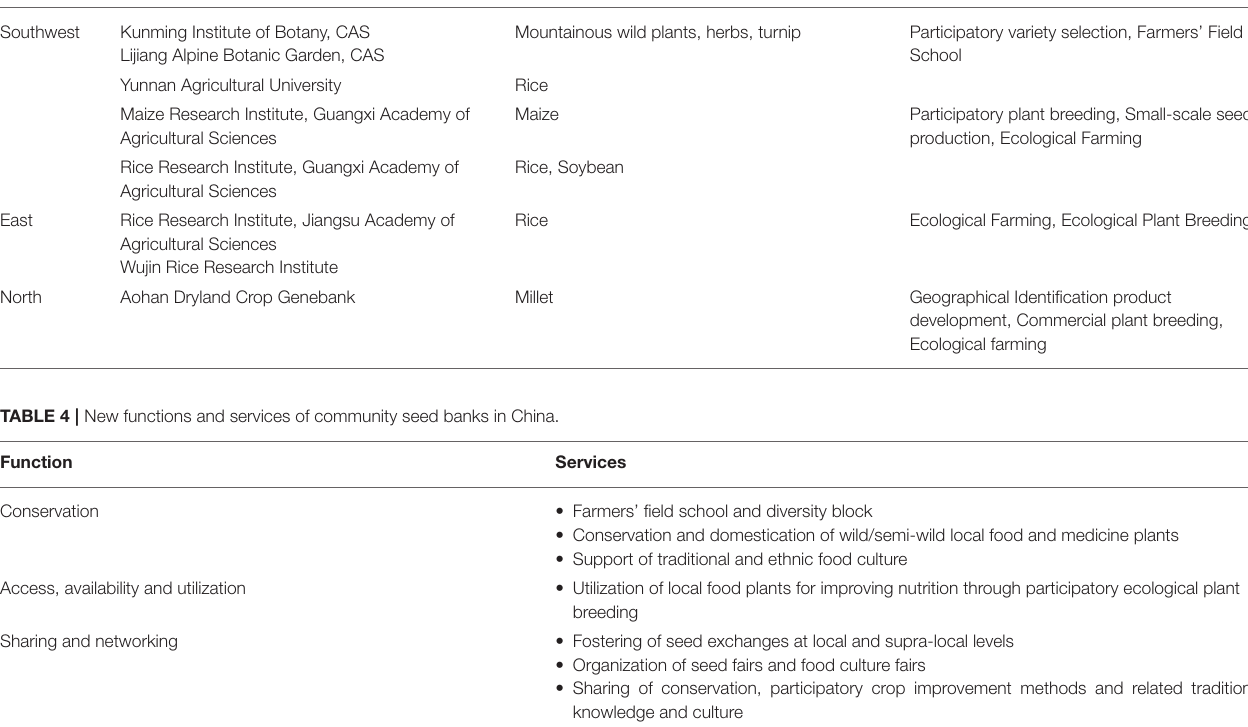
TABLE 3 | Organizational links of community seedbanks. Region